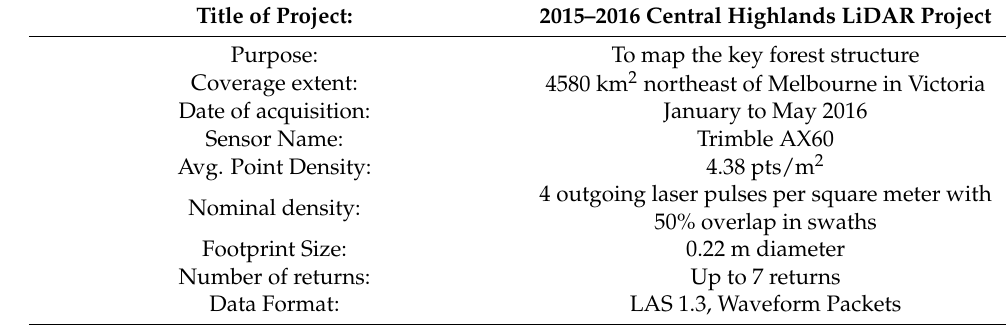
Table 2. Details of airborne LiDAR dataset used.